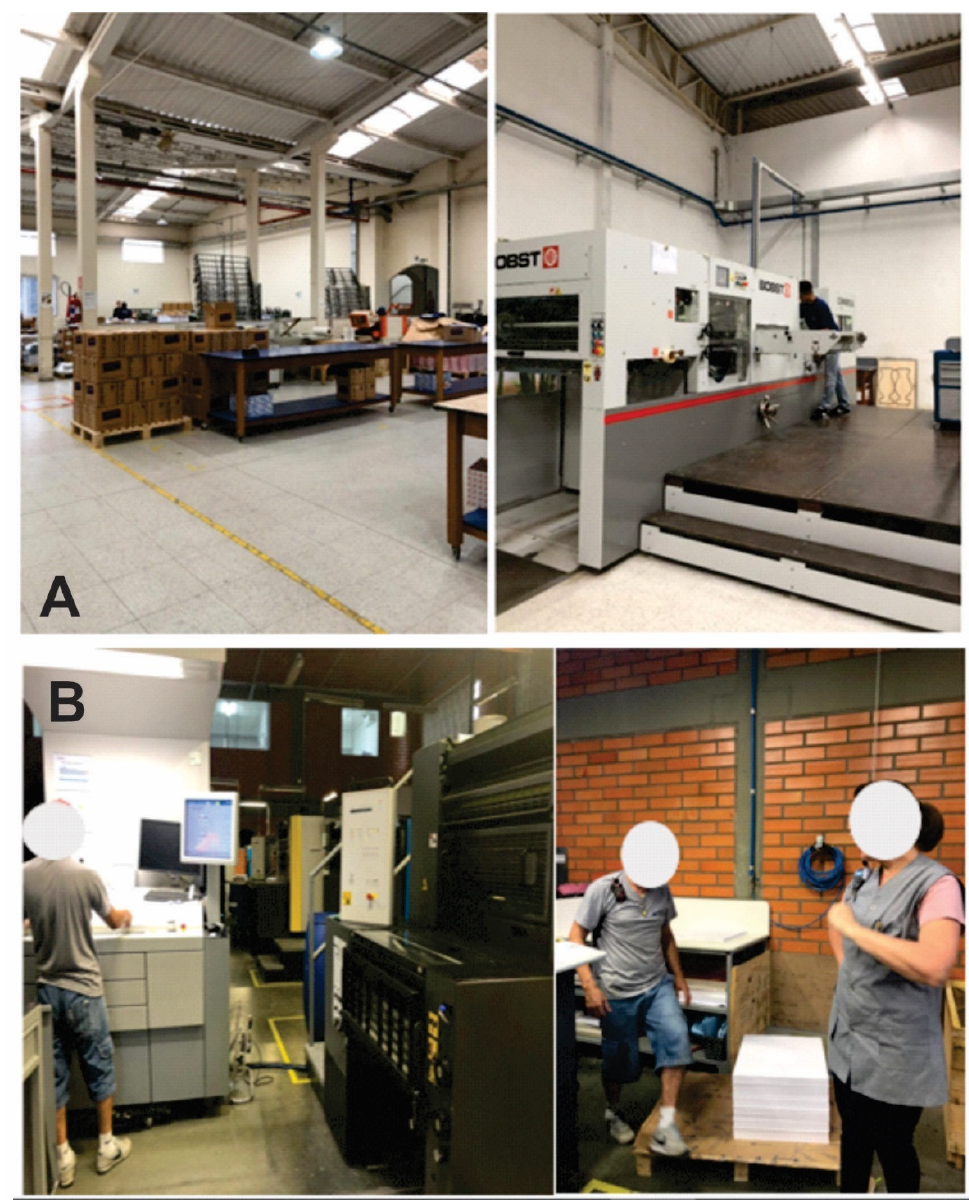
Figure 1. Images of printing equipment and setup locations at each of the companies ( A , B ).